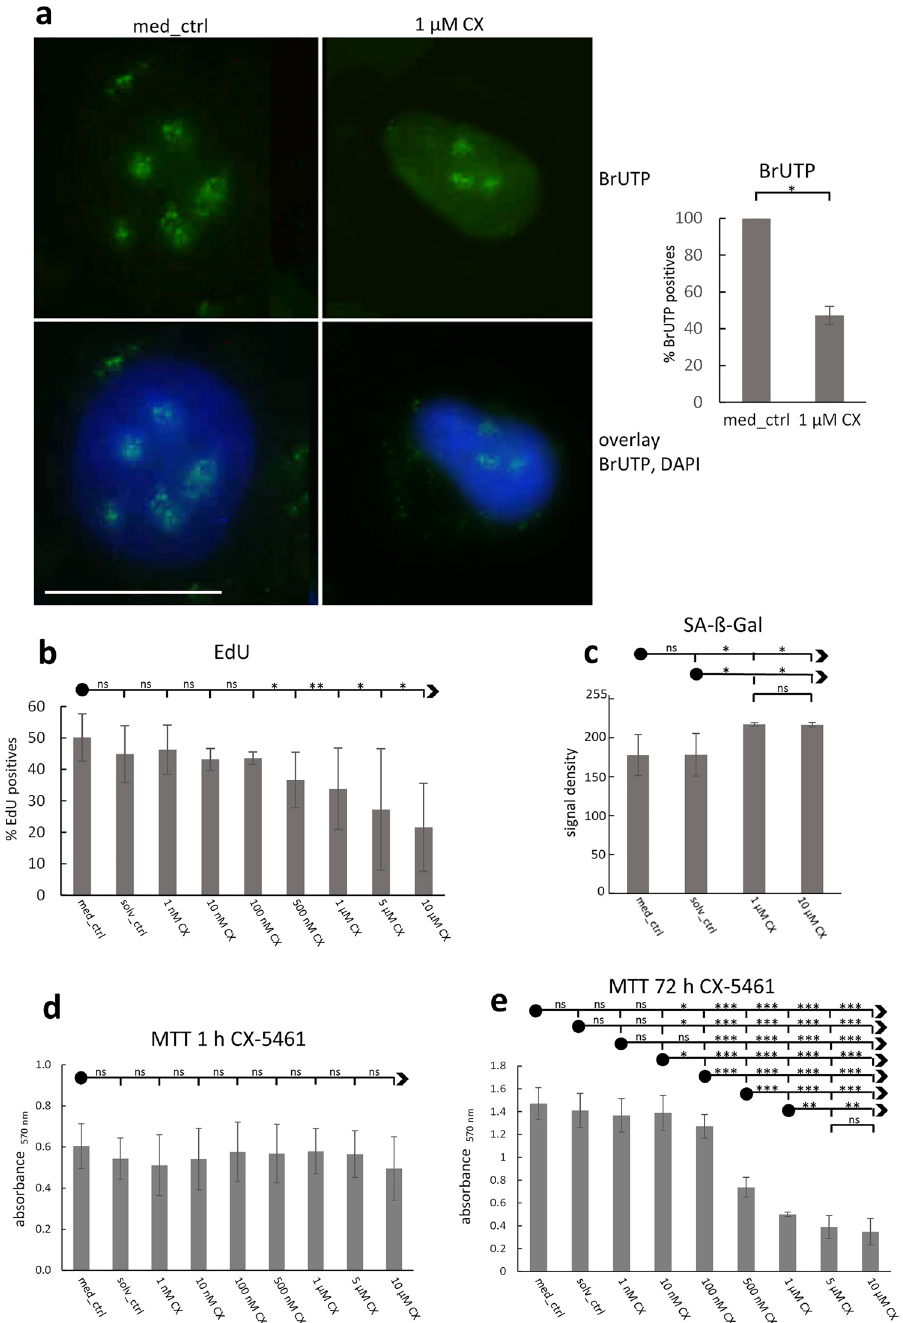
Figure 1. Effect of CX-5461 exposure on HeLa cell cultures. ( a ) Reduced amount of newly synthesized rRNA (green) at 1 µM CX-5461 exposure for 1 h in comparison to control cells visualized by BrUTP-incorporation into nascent transcripts (representative images; widefield imaging); chart shows percentage of BrUTP-positives among a total of 220 cells in 1 experiment; ( b ) 1 h exposure shows significant reduction of cells undergoing DNA replication beginning from 500 nM CX-5461 onwards measured by EdU incorporation (mean 7600 cells per category, 3 independent experiments); statistics: bullet is always used as anchor point for comparison (read: first “ns” compares med_ctrl with solv_ctrl, second “ns” compares med_ctrl with 1 nM CX, etc.); ( c ) senescence is significantly induced at exposure to 1 µM CX-5461 for 1 h as measured by SA-ß-Gal staining (mean of 7200 DAPI-stained nuclei per category (8-bit grey values); 2 independent experiments); ( d ) viability shows no significant differences after 1 h CX-5461 incubation (1 nM–10 µM) measured with an MTT assay whereas incubation for 72 h ( e ) leads to significantly reduced viability, particularly from 500 nM CX-5461 onwards ( d , e : 3 independent experiments (triplicates)). Graph bars display means, error bars represent standard deviations; Student´s t -test was applied. Bar = 10 µm, ns not significant, *P < 0.05, **P < 0.01, ***P <